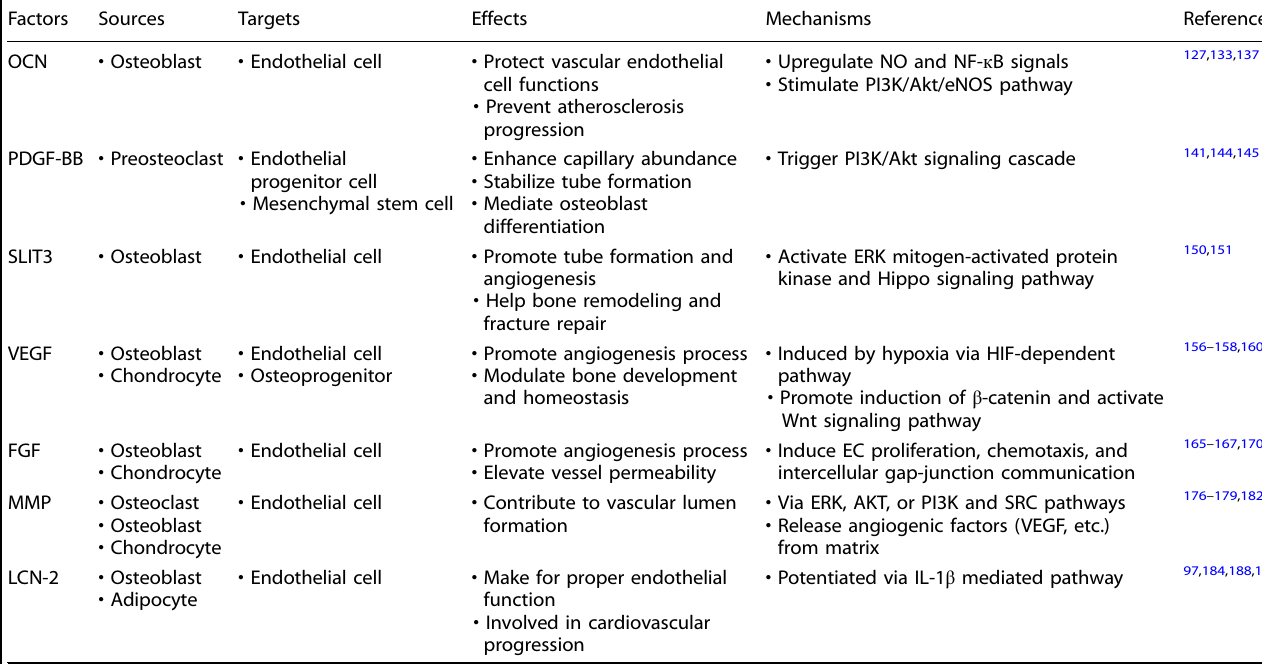
Table 3. Summary of skeleton-derived factors acting on vasculature